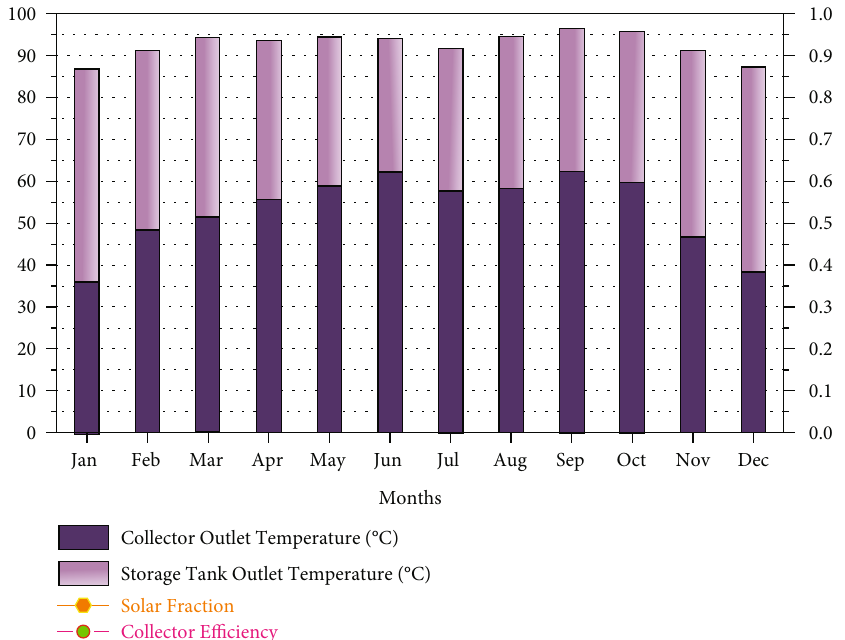
Figure 7: Monthly performance of evacuated glass tube collector.